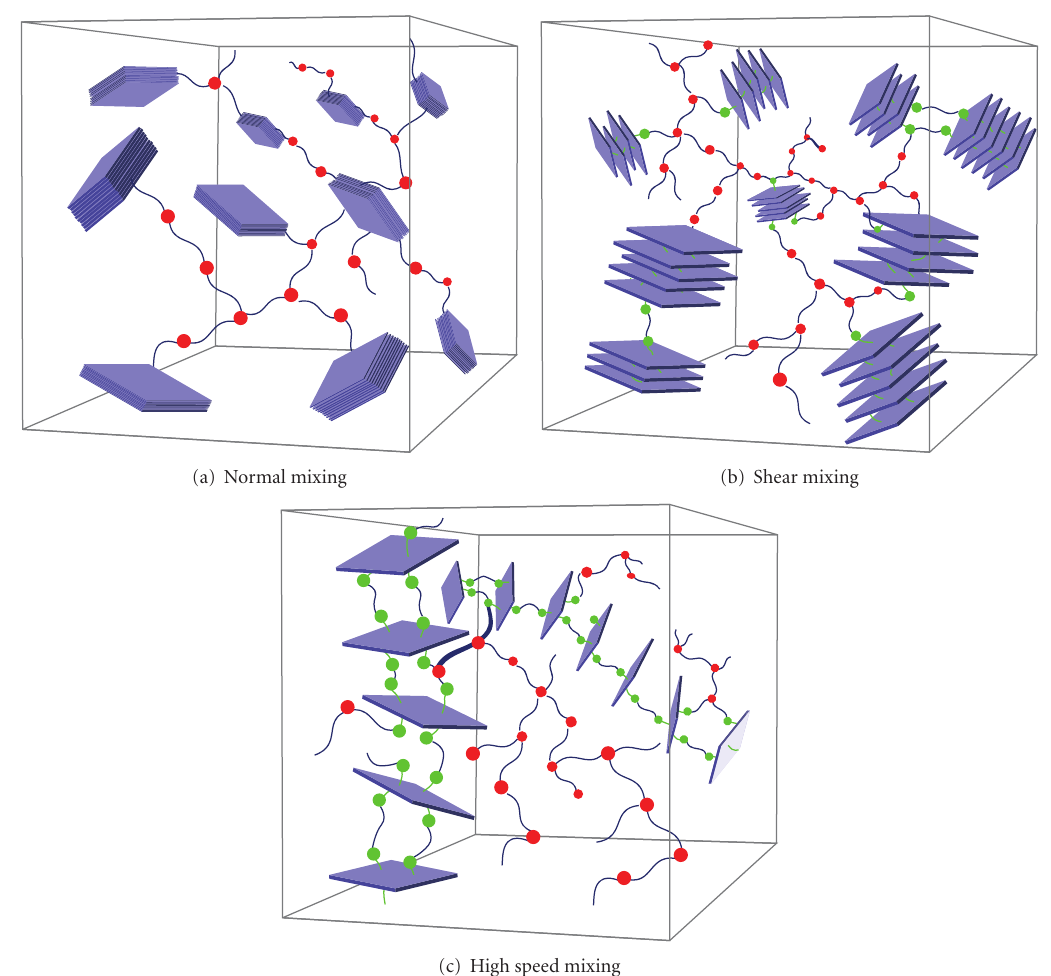
Figure 13: Model of three kinds of nanocomposites made by normal mixing, shear mixing, and high-speed mixing. (Black dot represents crosslink between epoxy resin and curing agent, and gray dot represents onium ion.)